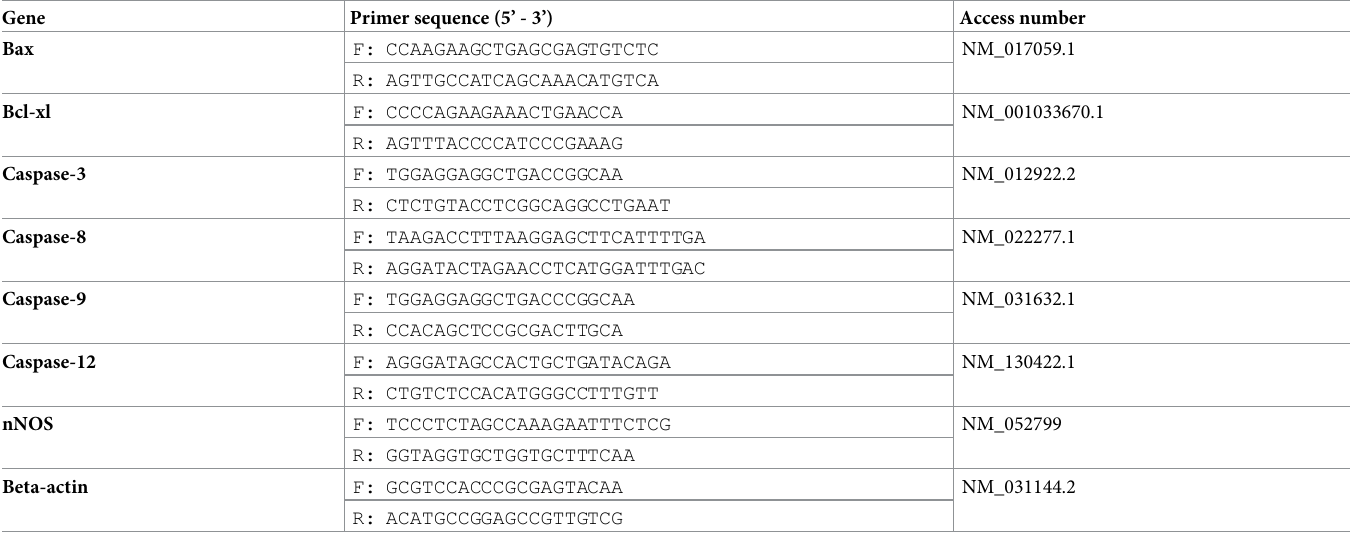
Table 1. Primer sequences for real time PCR